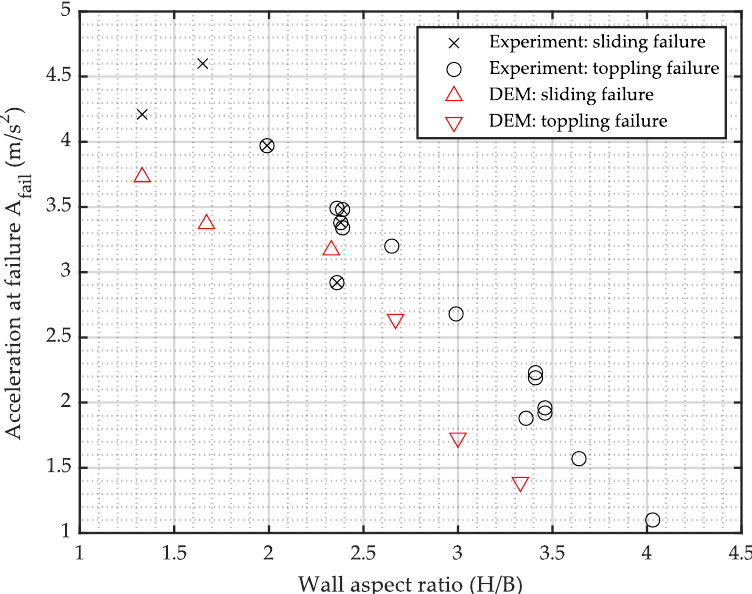
Figure 6. Comparison of the acceleration at failure ( A fail ) between the numerical simulations and experimental tests for different wall slenderness ( H/B